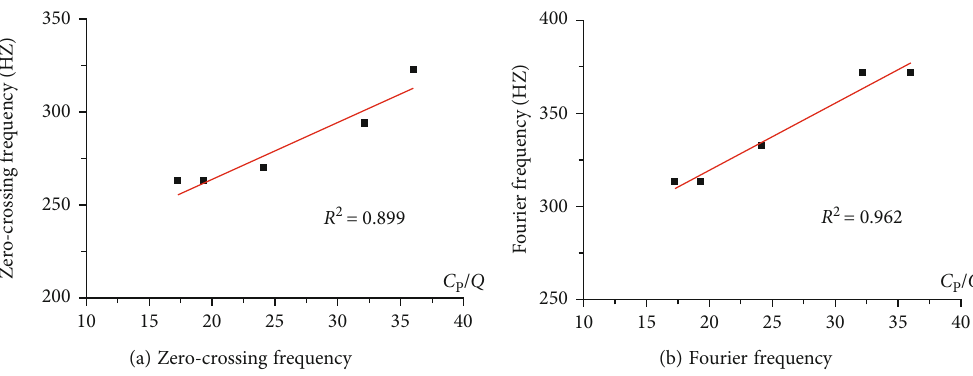
Figure 10: Linear fi tting relationship between the dominant frequency and C